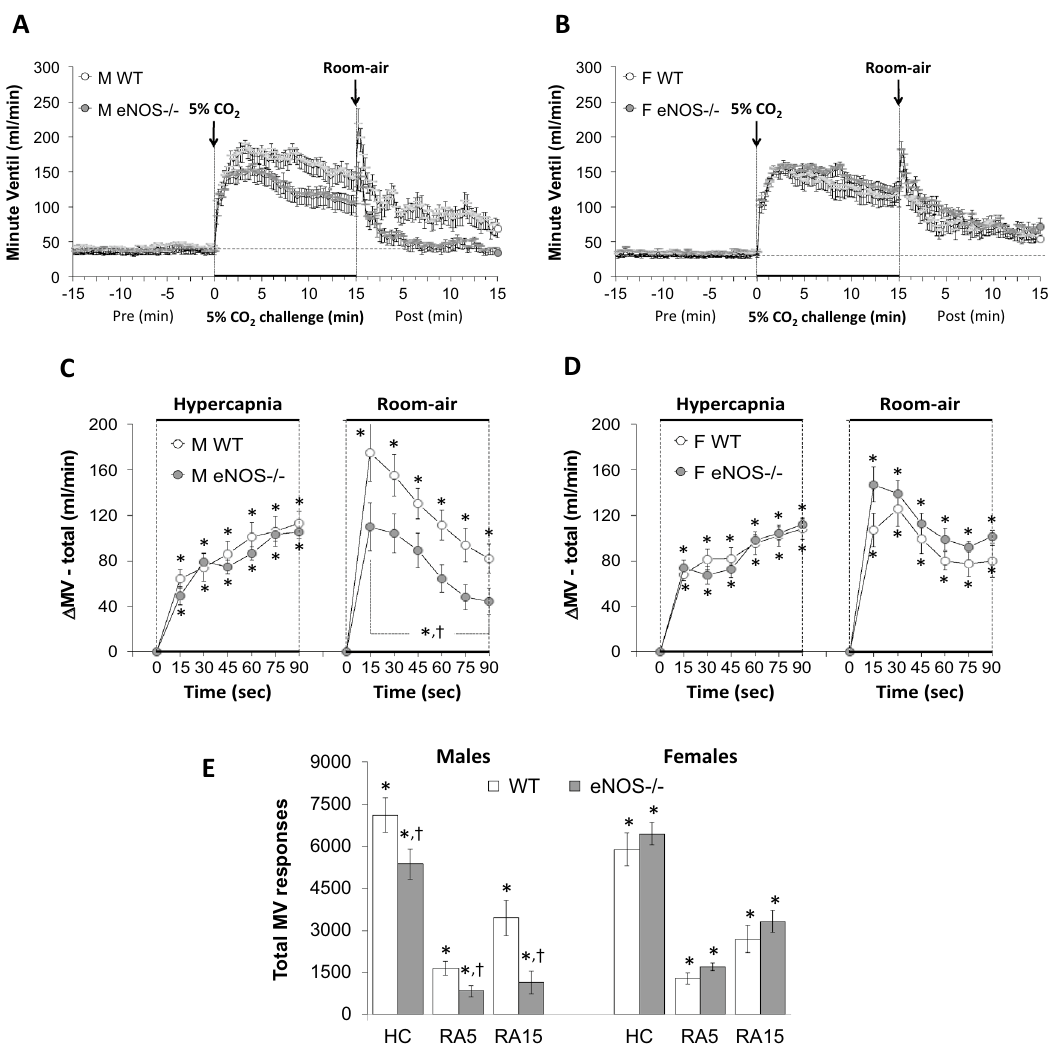
Figure 3. Panels ( A ) and ( B ) Minute Ventilation (MV) values before, during a hypercapnic (HC) gas challenge (5% CO 2 , 21% O 2 , 74% N 2 ) and upon return to room-air in male (M) and female (F) wild-type (WT) and eNOS knock-out (eNOS-/-) mice. Panels ( C ) and ( D ) Arithmetic changes in MV in male and female WT and eNOS-/- mice during the first 90 s of exposure to the HC challenge and the first 90 s upon return to room-air. Panel ( E ) Total changes in MV in male and female WT and eNOS-/- mice during the HC challenge and during the first 5 min (RA5) and entire 15 min (RA15) return to room-air. The data are presented as mean ± SEM. * P < 0.05, significant change from pre-values. † P < 0.05, eNOS-/- versus WT within each